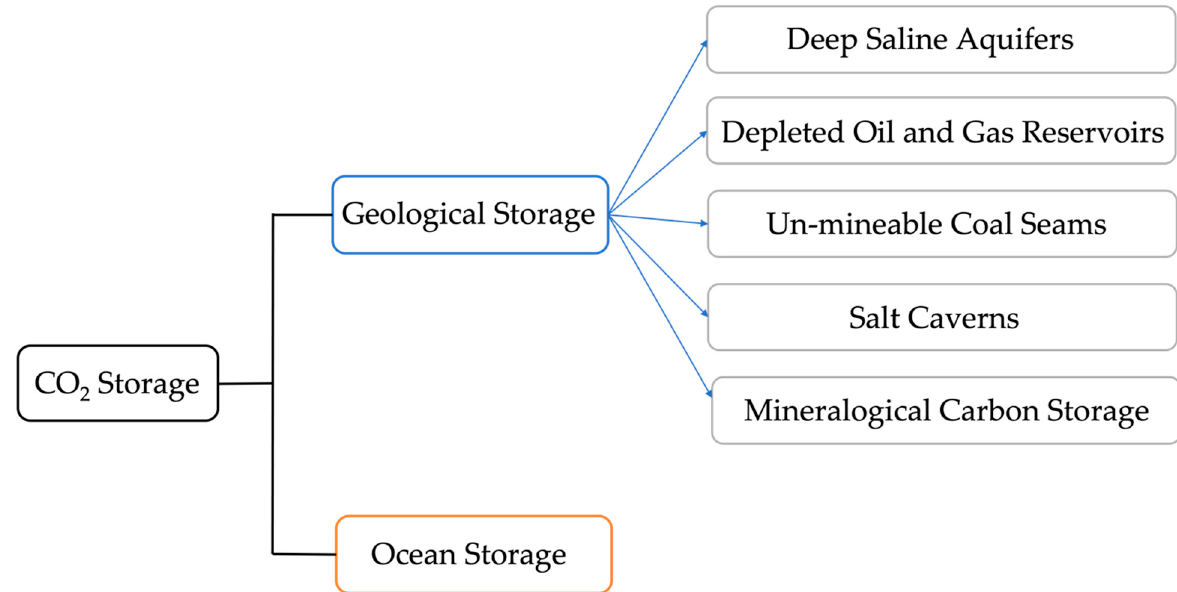
Figure 5. CO 2 storage classifications.